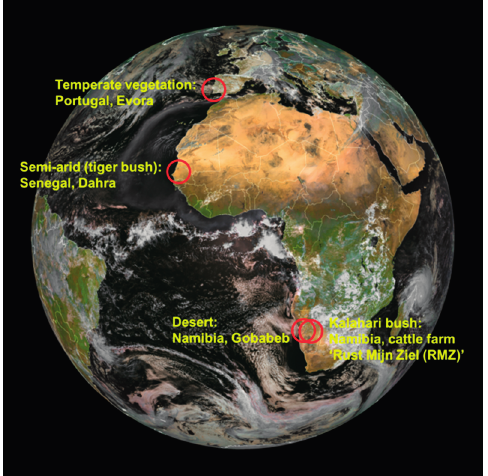
Figure 1. Locations of the Karlsruhe Institute of Technology’s (KIT) validation stations on the Meteosat Second Generation (MSG)/Spinning Enhanced Visible and Infrared Imager (SEVIRI)